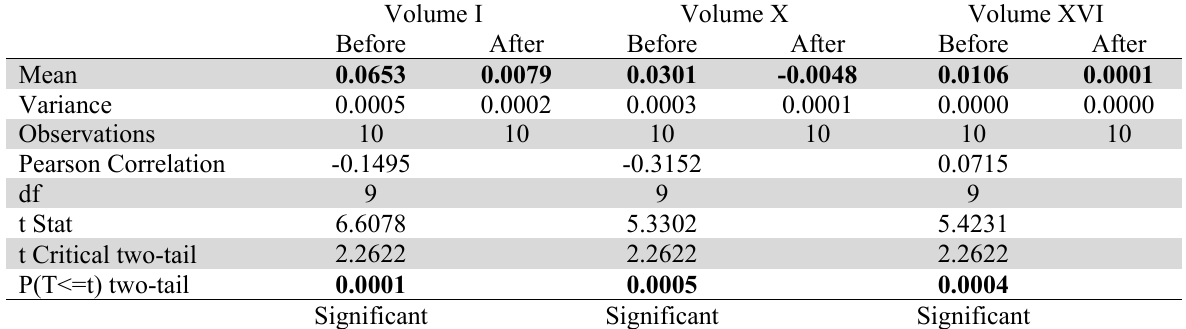
Paired t -test of two samples for means of CAR on JCI (volume I, volume X, and volume XVI) Volume I Volume X Volume XVI Before After Before After Before After Mean